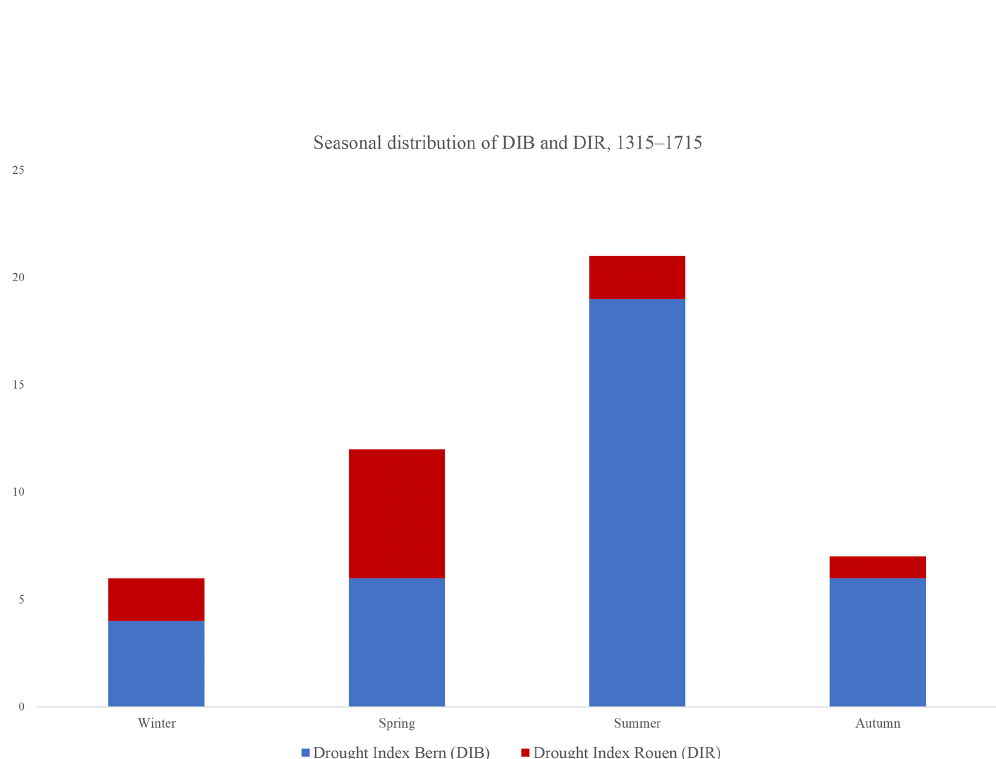
Figure 1. Drought index of Bern (DIB) and drought index of Rouen (DIR), 1315–1715.